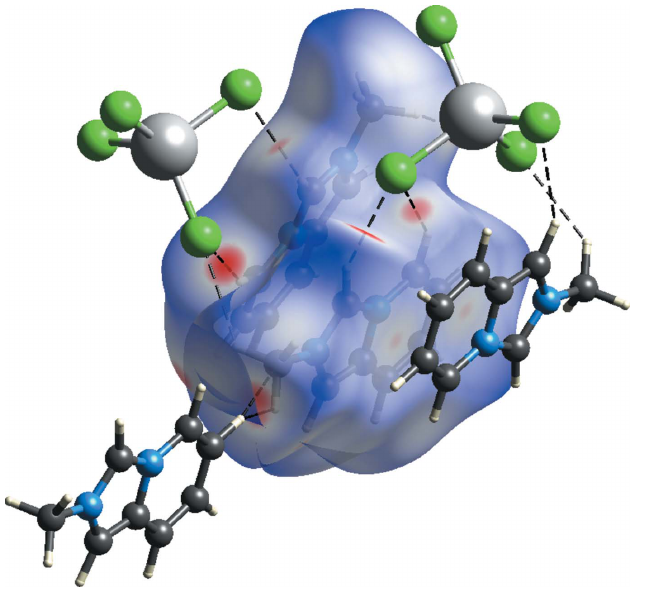
(Fig. 2, Table 2) at the H (cid:3) (cid:3) (cid:3) Cl distances below the van der Waals contact limit of 2.85 A˚ (Mantina et al. , 2009).